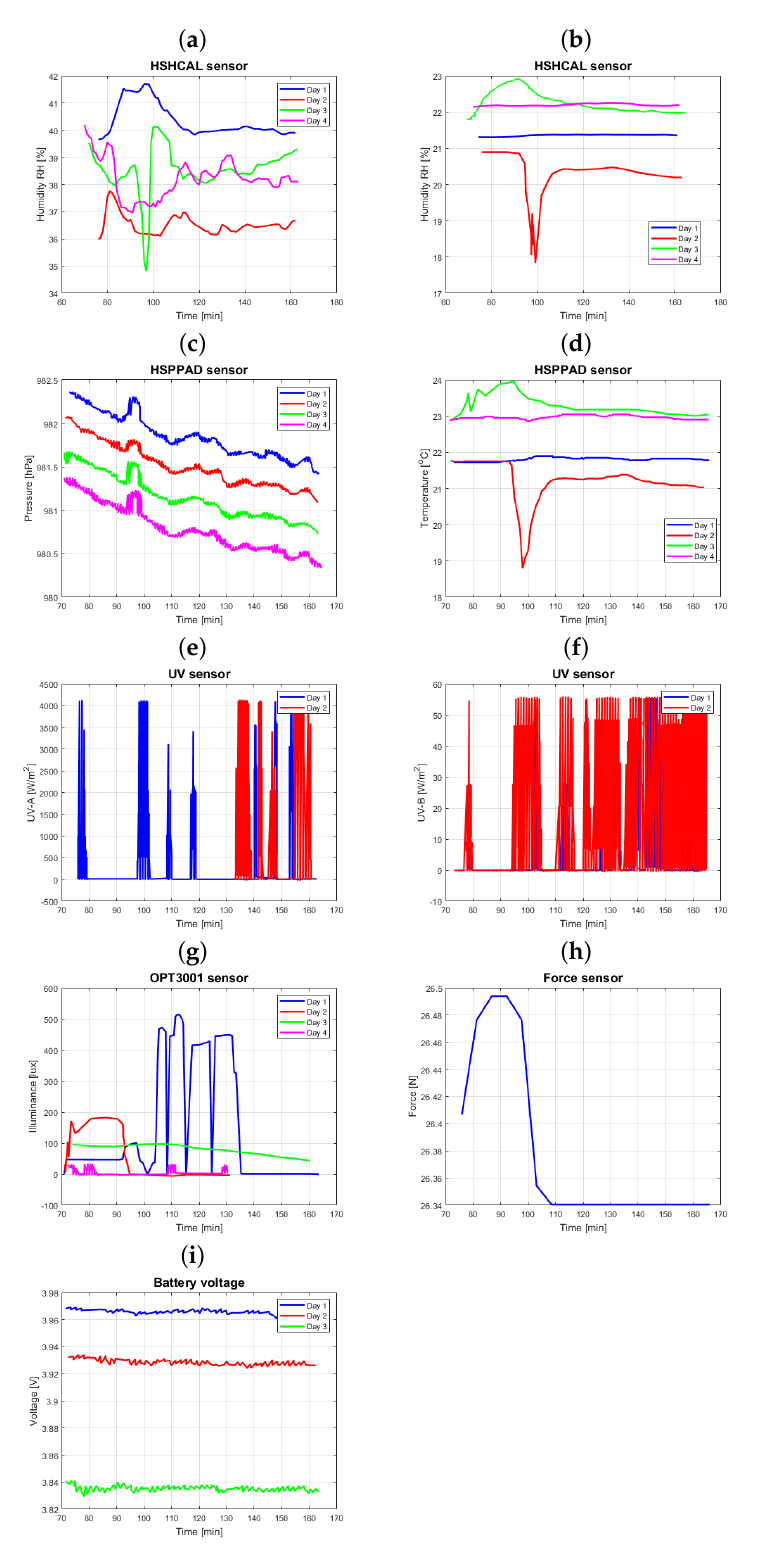
Figure 18. Exemplary real time plots of the measurements, where signals are from: ( a ) humidity sensor, ( b ) humidity sensor (dry air), ( c ) pressure sensor, ( d ) temperature sensor, ( e ) UV sensor, ( f ) second UV sensor, ( g ) illuminance sensor, ( h ) force sensor, ( i ) voltage